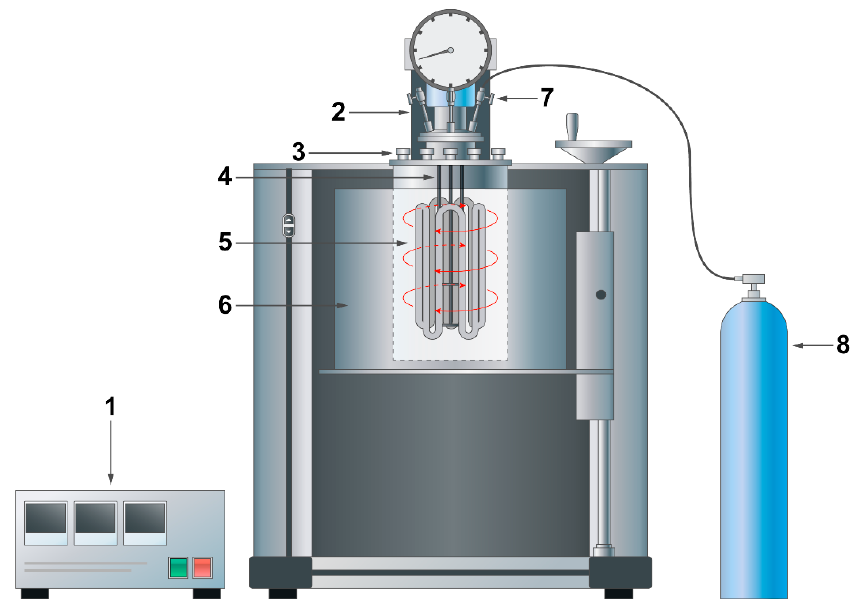
Figure 2. Schematic of the experimental setup for the leaching of lead slime: 1—controller, 2—outlet valve, 3—lid, 4—stirring, 5—container, 6—heating, 7—inlet valve, 8—oxygen.